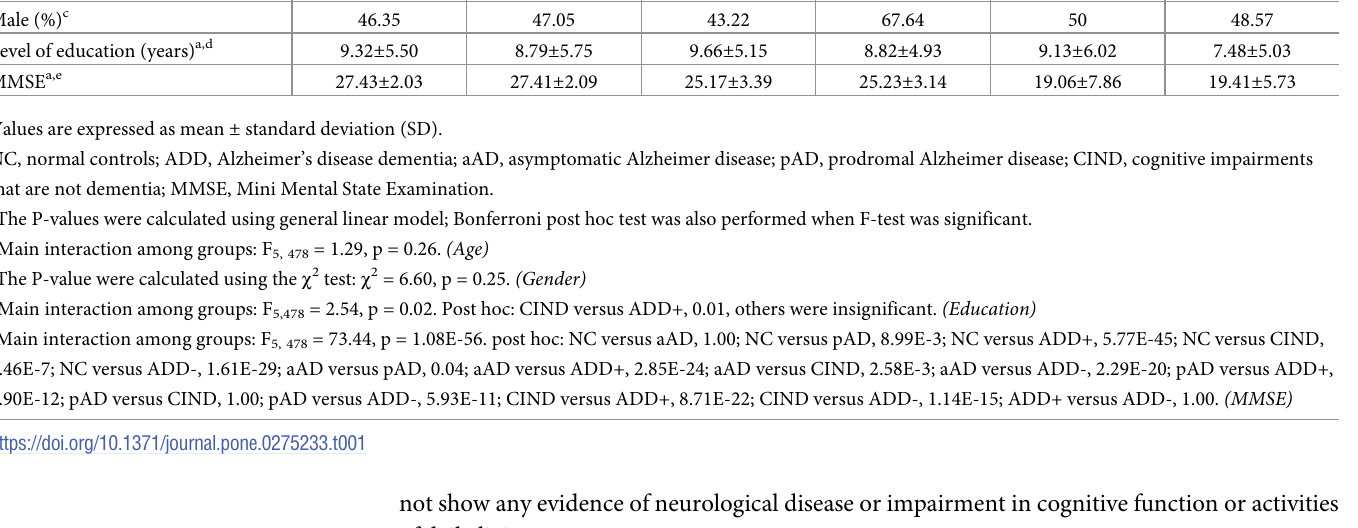
Table 1. Demographic characteristics of the study population.